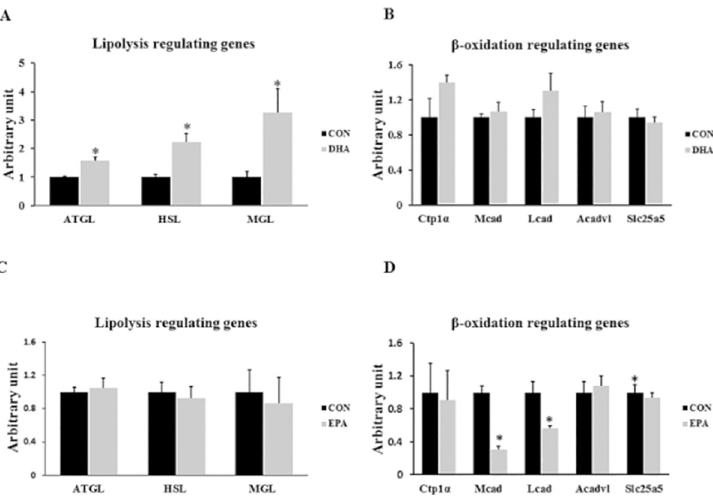
and 55% ± 10.9 respectively); while, Err α and PGC1 β showed no difference between control groups and those treated with DHA or EPA. On the proteomic level, PGC1 α was significantly reduced in the DHA treated group only (Fig 7) .